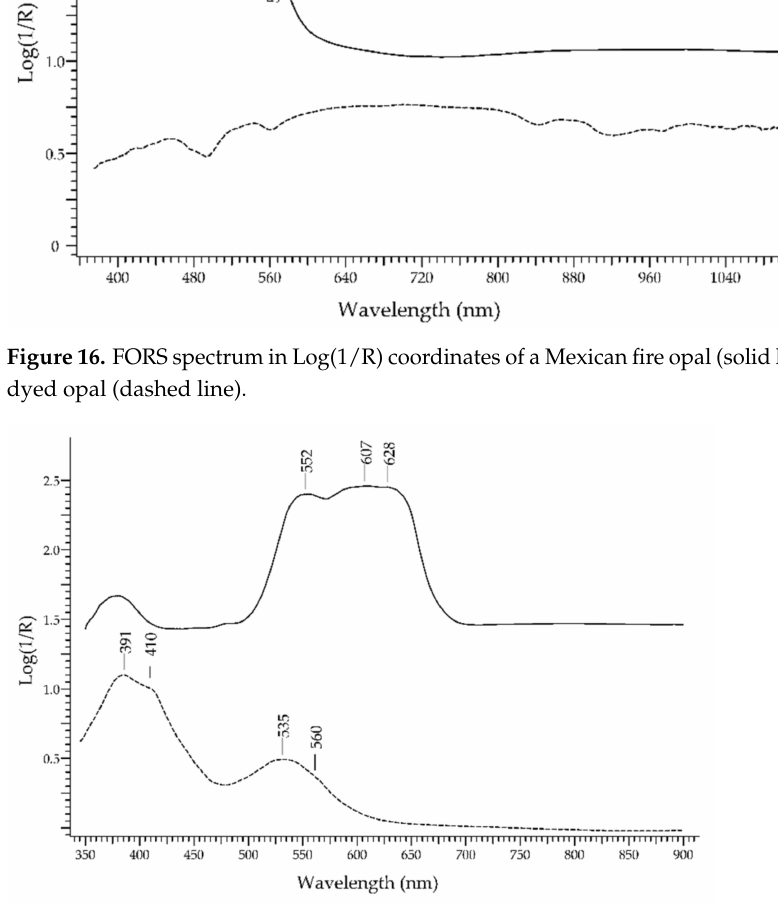
Figure 17. FORS spectrum in Log(1/R) coordinates of a red spinel (solid line) and a blue spinel (dashed